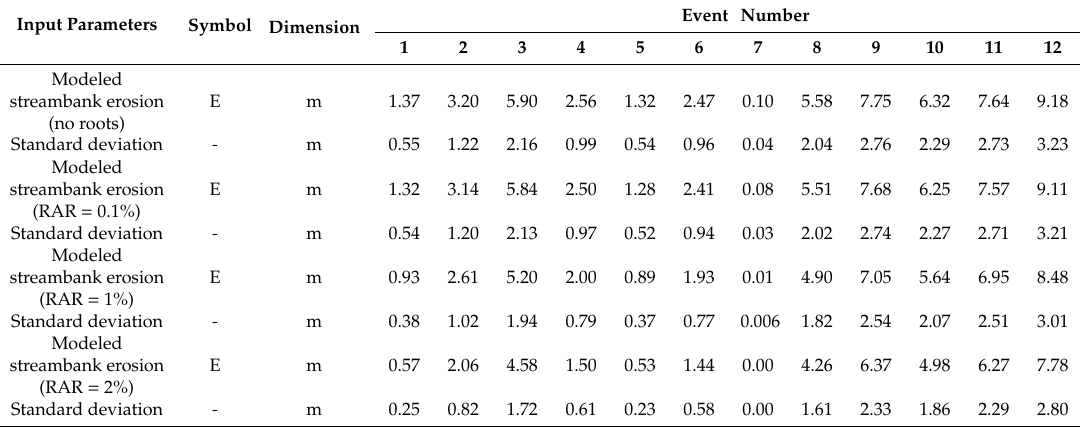
Table 6. Modeled streambank erosion for the Thur River catchment.